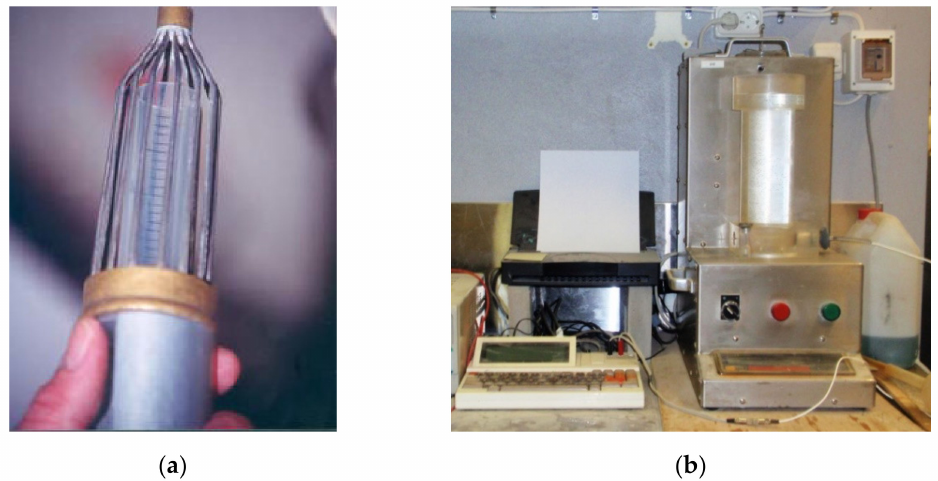
Figure 3. Apparatus for air void analysis (AVA) in the fresh state: ( a ) Wire cage surrounding the syringe used to collect the sample for the AVA test; ( b ) AVA test set-up. Riser column with inverted pan on (on the right) and computer and printer that process the information (on the